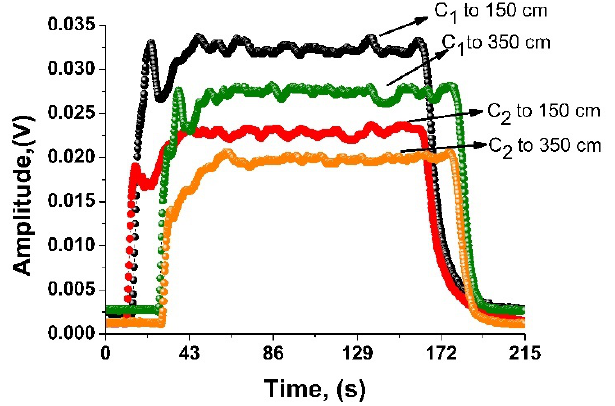
Figure 4. Fourier coefficients C 1 and C 2 corresponding to chamber lengths of 150 and 350 cm.